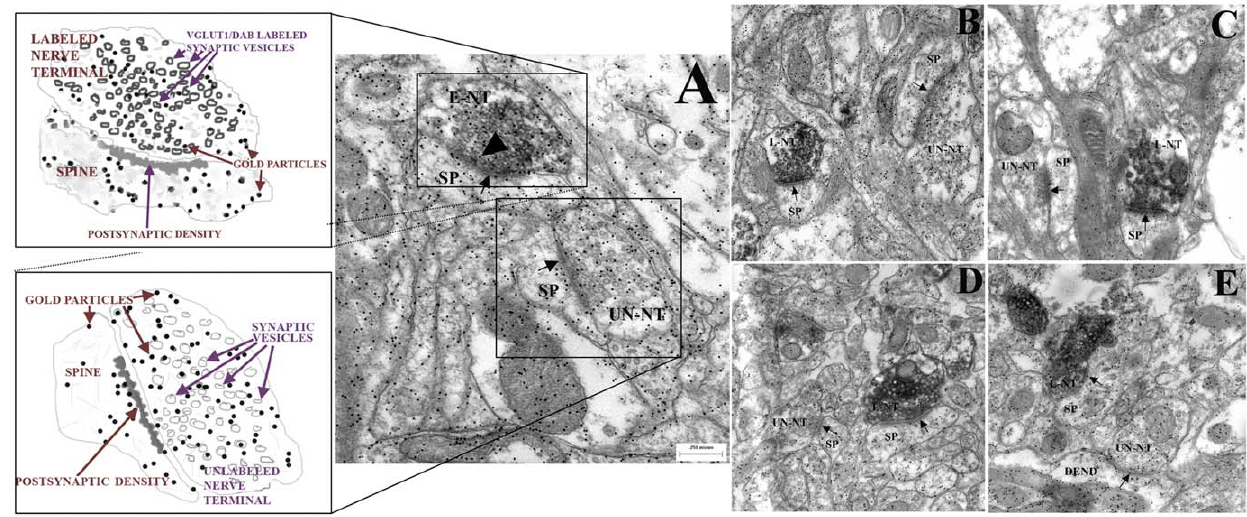
Figure 2. Immuno-gold labeled glutamate particles in VGLUT1-labeled and -unlabeled terminals. (A) Control . Electron photomicrographs of VGLUT1-labeled (L-NT) and -unlabeled (UN-NT) nerve terminals making asymmetric synaptic contacts (arrow) onto dendritic spines (SP). The 10 nm gold particles within the nerve terminals (see arrowhead in the L-NT) indicate the location of an antibody against glutamate. The inserts show labeled details of a terminal containing VGLUT1-immunoreactive synaptic vesicles (above) and a terminal containing unlabeled synaptic vesicles (below). (B) 6-OHDA lesion . L-NT and UN-NT both make asymmetric synaptic contacts (arrows) with SPs. The density of immuno- gold labeling within these terminals is similar to that of the control group (A). (C) 6-OHDA/STN lesion : L-NT and UN-NT make asymmetric synaptic contacts (arrows) with SPs. The density of nerve terminal immuno-gold labeling is significantly reduced compared to the control (A) and 6OHDA (B) tissue. (D) 6-OHDA/STN stimulation . Both L-NT and UN-NT make asymmetrical synaptic contacts (arrows) with SPs. The density of nerve terminal glutamate immuno-gold labeling is similar to that seen in the 6-OHDA/STN lesion group (C). (E) 6-OHDA/Sham-Stim . The L-NT makes an asymmetric synaptic contact with the SP, and the UN-NT makes an asymmetric synaptic contact with a dendritic shaft (DEND). The density of nerve terminal glutamate immuno-gold labeling is greater than in the 6-OHDA/STN lesion (C) and 6-OHDA/STN stimulation (D) tissue. Calibration bar: 0.25 microns.